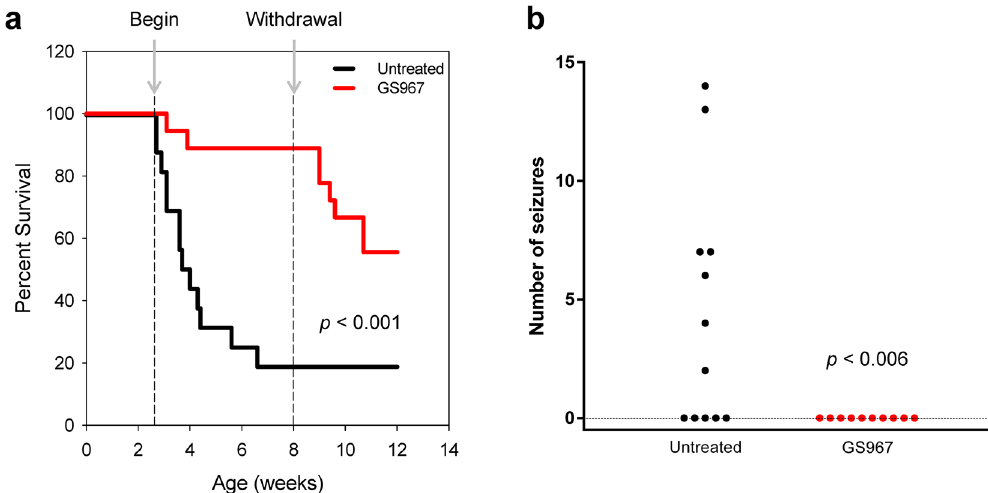
Figure 1. GS967 improved survival and reduced seizure frequency of Scn1a + / − mice. ( a ) Survival curves comparing untreated and GS967-treated Scn1a + / − mice. Treatment commenced at P18 (first dashed line) and was withdrawn at 8 weeks (second dashed line), with n = 18–37 mice per group. Survival difference between groups was significant ( p < 0.001; Mantel-Cox log-rank test). ( b ) Number of seizures in 48 hours observed for untreated and GS967-treated Scn1a + / − mice (n = 10–12 mice per group) was significantly different ( p < 0.006; non-parametric Mann-Whitney